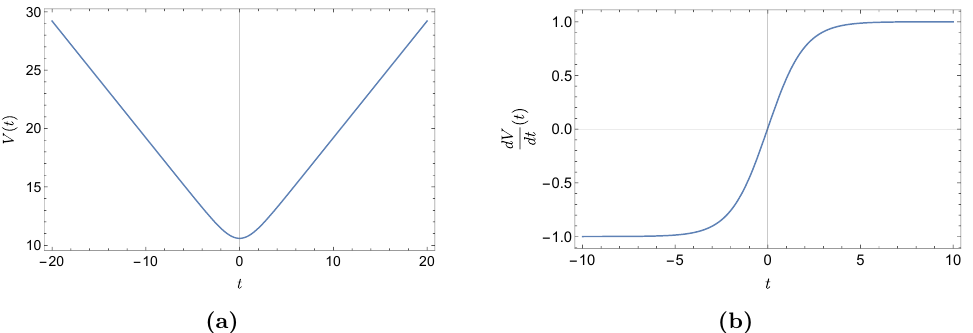
Figure 3. Volume and its time derivative as a function of the boundary time t with R b = 100